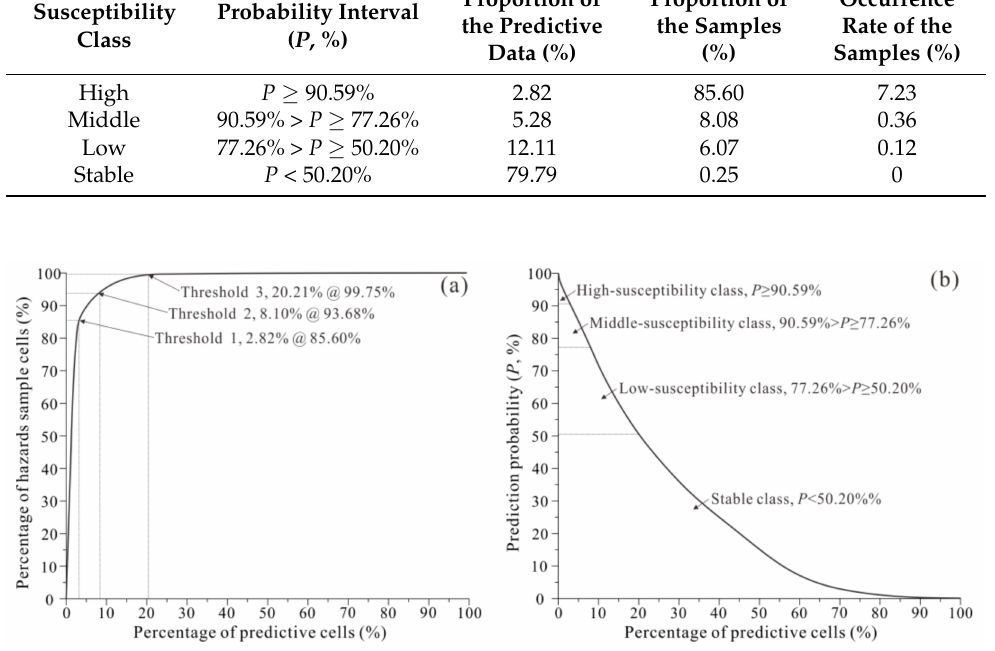
Figure 12. Analysis of capture-efficiency curve ( a , b ) prediction probability curve for zonation of the